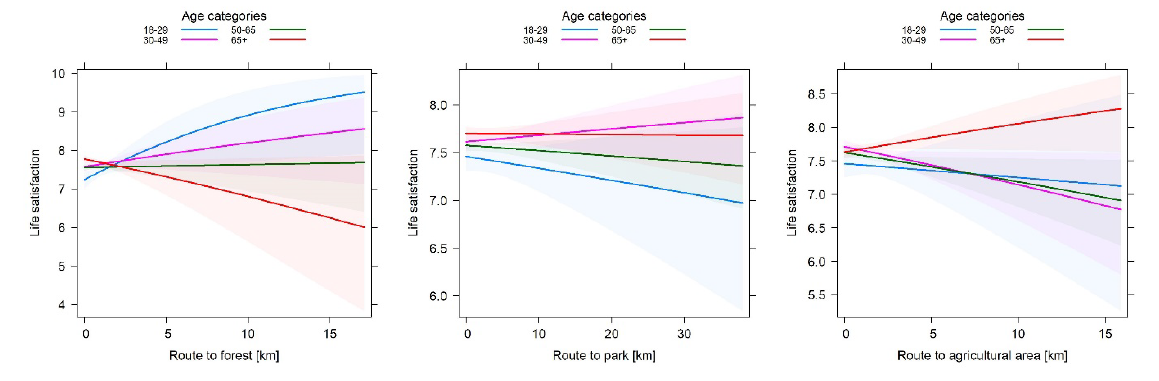
Figure S6 . Mutually adjusted associations of proximity to greenspace with life satisfaction by age categories, adjusted for life satisfaction in the past, sex, household income, financial worries, canton, degree of urbanisation, month of entry, and NDVI